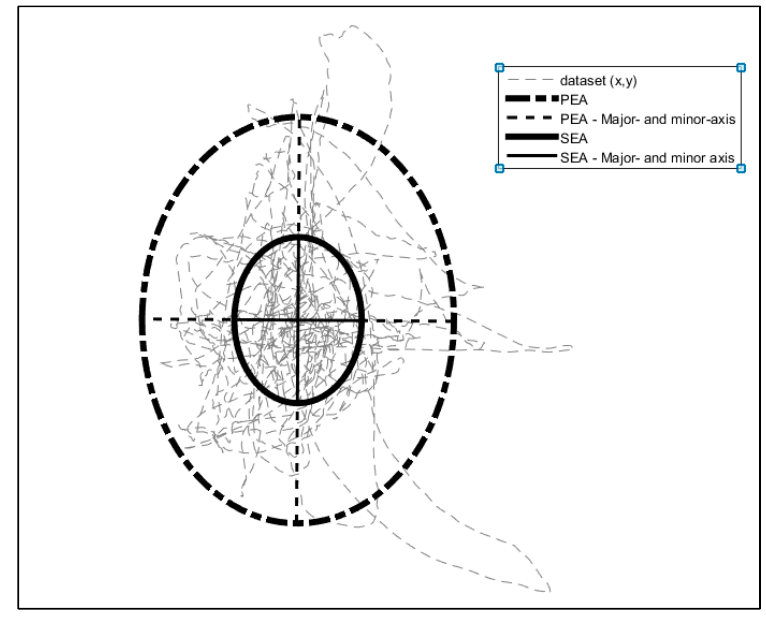
Figure 2. Representation of the PEA and SEA. Major and minor-axis of PEA and SEA are represented.